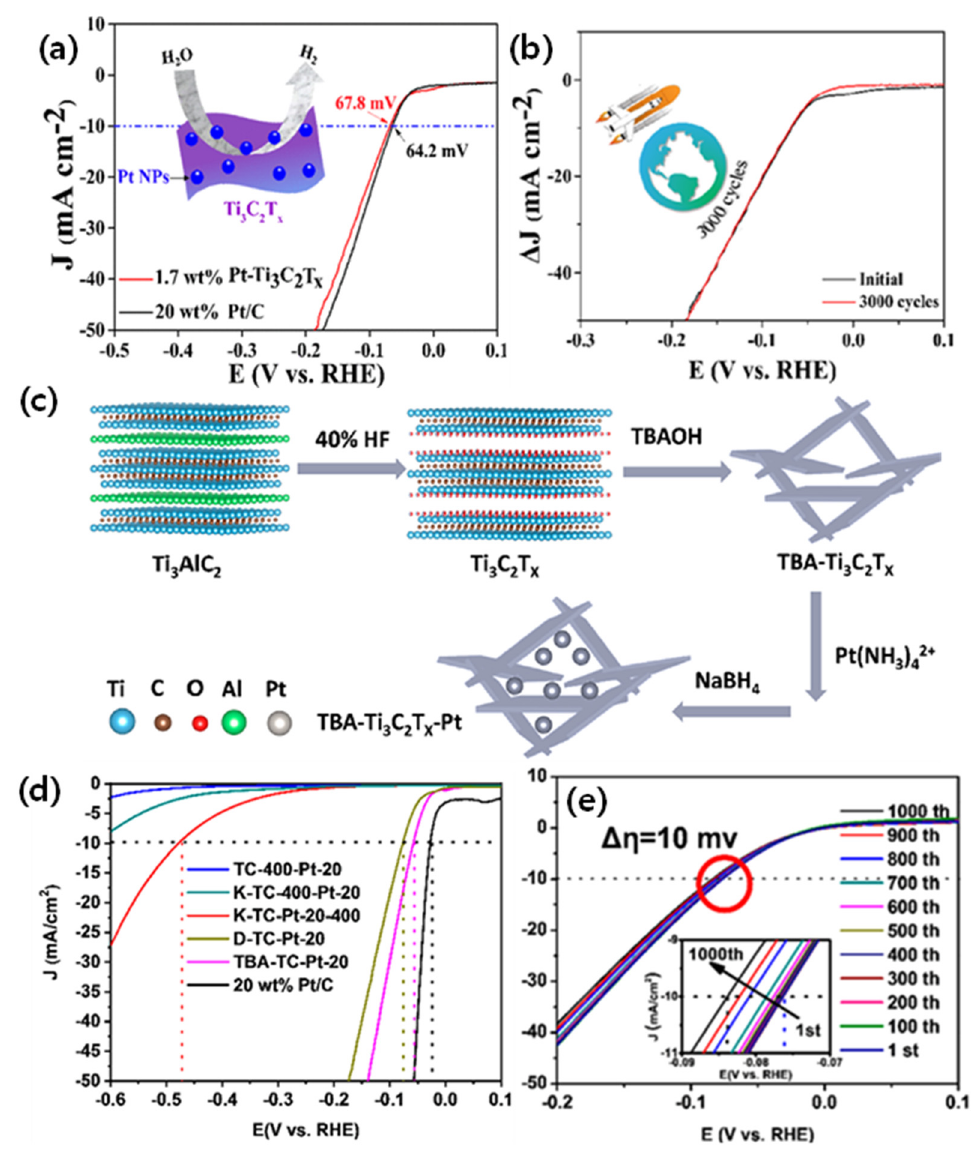
Figure 8. ( a ) Linear sweep voltammetry curves ( b ) Plotting of current—density difference ( ∆ J) against the voltage scan rate of 1.7 wt% Pt-Ti 3 C 2 T x initial and 3000th cycle. (Reprinted with permission from Ref. [54]. Copyright 2020, American Chemical Society). ( c ) Schematics of the preparation process of TBATi 3 C 2 T x -Pt. ( d ) Polarization curves of Pt deposited on the supports in 0.5 M H 2 SO 4 . ( e ) Polarization curves of TBA-Ti 3 C 2 T x -20 obtained for 1000 cycles (Reprinted with permission from Ref. [81]. Copyright 2019, American Chemical Society).